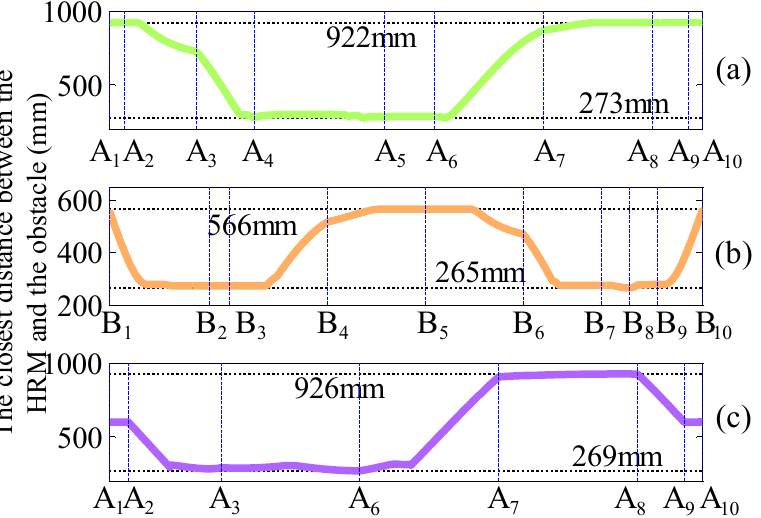
Figure 17. Schematic diagram of the distance between the manipulator and obstacle. ( a ) The distance between manipulator and obstacle in obs1; ( b ) The distance between manipulator and obstacle in obs2; ( c ) The distance between manipulator and obstacle in obs3.